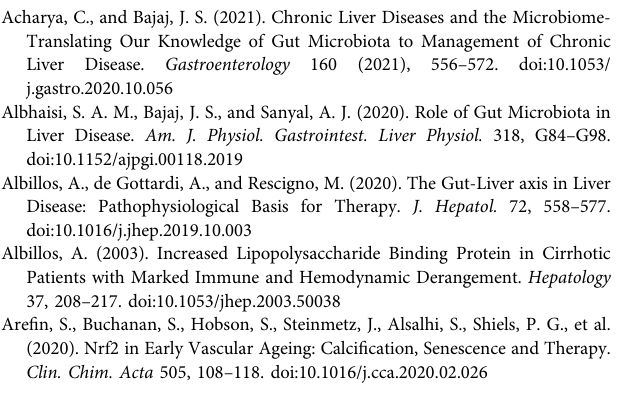
Frontiers in Pharmacology |